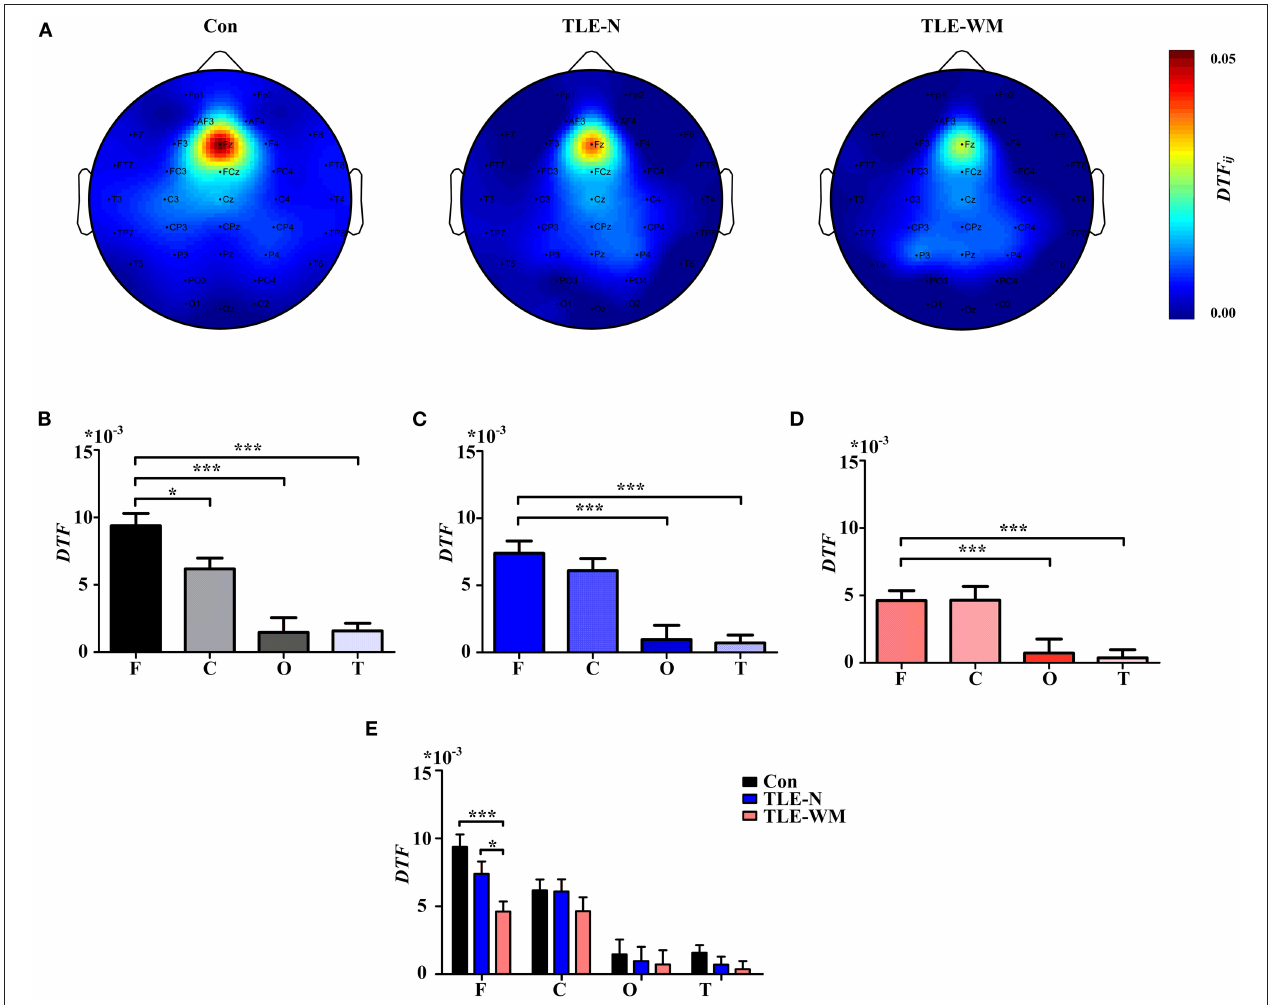
FIGURE 6 | Spectral distribution and histogram showing functional connectivity strength in the theta frequency band during the WM encoding phase across the three groups. (A) Spectral distribution of functional connectivity strength across the three groups. Connectivity strength is indicated by color. Histogram of connectivity strength in the theta frequency band associated with different brain regions in the Con group (B) , the TLE-N group (C) , and the TLE-WM group (D) . Connectivity strength in the frontal region was prominent. (E) Comparison of connectivity strength in the theta frequency band associated with different brain regions across the three groups. Connectivity strength in the frontal region of the TLE-WM group was weak. * p < 0.05 and *** p <